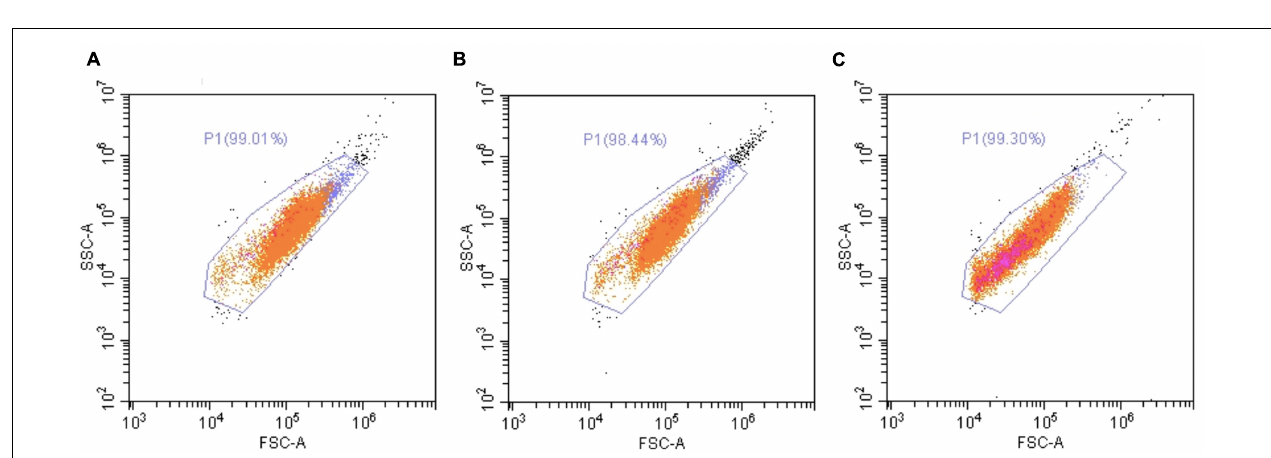
FIGURE 5 | Cellular parameters of gastrodermal cultivated cells under H 2 O 2 treatments and resilience phase. Cell viability (A) and cell growth rate (B) were measured under cell treatment with H 2 O 2 at 200 and 500 µ M and during resilience phase (back to control condition for 7 days): 0 µ M H 2 O 2 (control condition; white bars), 200 µ M H 2 O 2 (gray bars) and 500 µ M H 2 O 2 (black bars). Cell viability and growth rate are expressed relative to the control condition (ratio of the control condition). Data are represented as means with standard error bars. Significant differences between control and treatments are expressed by ∗ p < 0.05, ∗∗ p < 0.01, and ∗∗∗ p < 0.001.